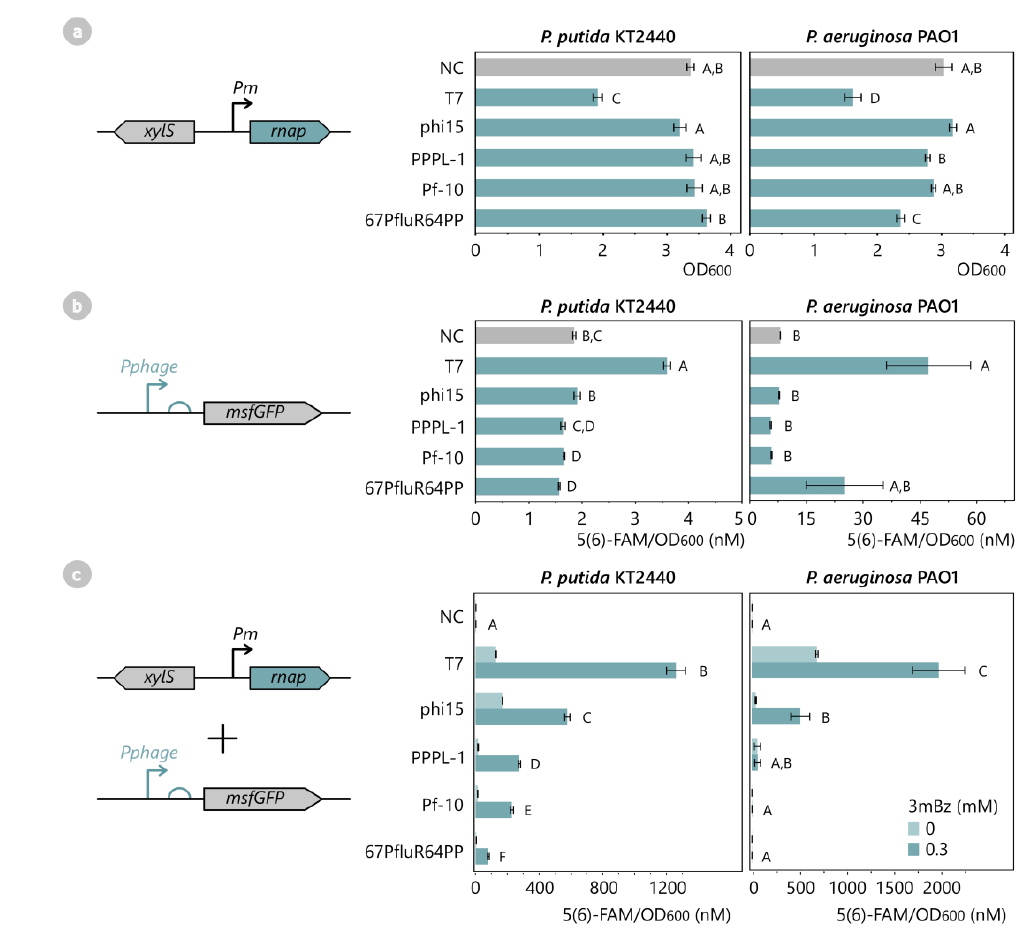
Figure 3. ( a ) Effect of phage RNAP expression on cell growth of P. putida KT2440 and P. aeruginosa PAO1. The RNAPs of phages T7, phi15, PPPL-1, Pf-10, and 67PfluR64PP were introduced in P. putida and P. aeruginosa , as well as an empty pSTDesX vector as a negative control (NC). All samples were induced with 1 mM 3mBz at OD 600 0.3 for 12 h. Bars and error bars represent the mean OD 600 and standard error of four biological replicates after 12 h induction, respectively. Samples not connected by the same letters are significantly different (Tukey HSD, α = 0.05). ( b ) Recognition of the phage promoter by the host RNAP of P. putida KT2440 and P. aeruginosa PAO1. MsfGFP reporter constructs with the phage-specific promoters of T7, phi15, PPPL-1, Pf-10, and 67PfluR64PP and a promoterless construct (NC) were introduced in P. putida or P. aeruginosa and were monitored for 12 h for OD 600 and msfGFP levels. As the phage RNAPs were not present, no msfGFP expression was expected unless the phage promoter was also recognized by the host RNAP. Bars and error bars represent the mean value and standard error of four biological replicates after 12 h cell growth, respectively. Samples not connected by the same letters are significantly different (Tukey HSD, α = 0.05). ( c ) T7-like phage RNAPs generate high msfGFP expression levels from their putative phage promoter in P. putida KT2440 and P. aeruginosa PAO1. All phage RNAPs and corresponding phage promoter-msfGFP reporter constructs, including empty control vectors (NC), were introduced in P. putida and P. aeruginosa and were induced with 0.3 mM 3mBz for a 12 h period. The fluorescent intensity was normalized for OD and expressed as an equivalent 5(6)-FAM concentration (nM). Bars and error bars represent the mean value and standard error of four biological replicates after 12 h induction, respectively. Samples not connected by the same letters are significantly different (Wilcoxon ( P. putida ) and Student’s t -test ( P. aeruginosa ), α = 0.05). The complete growth curves and fluorescence expression levels over time of ( a – c ) are provided in Figure S3.